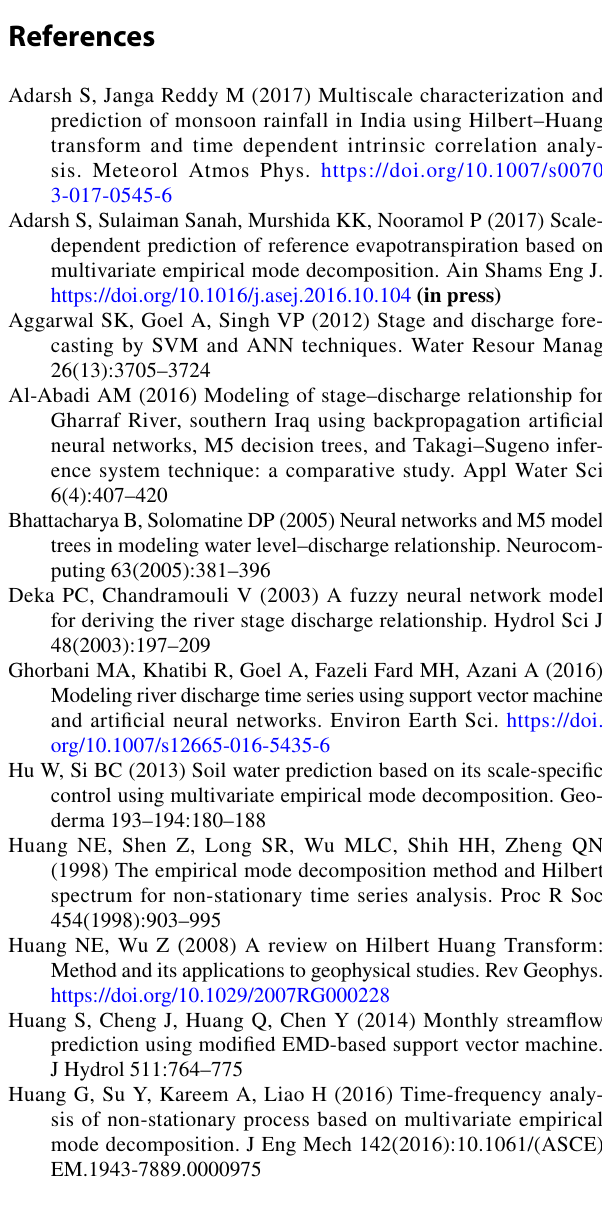
HF high flow, LF low flow, MF